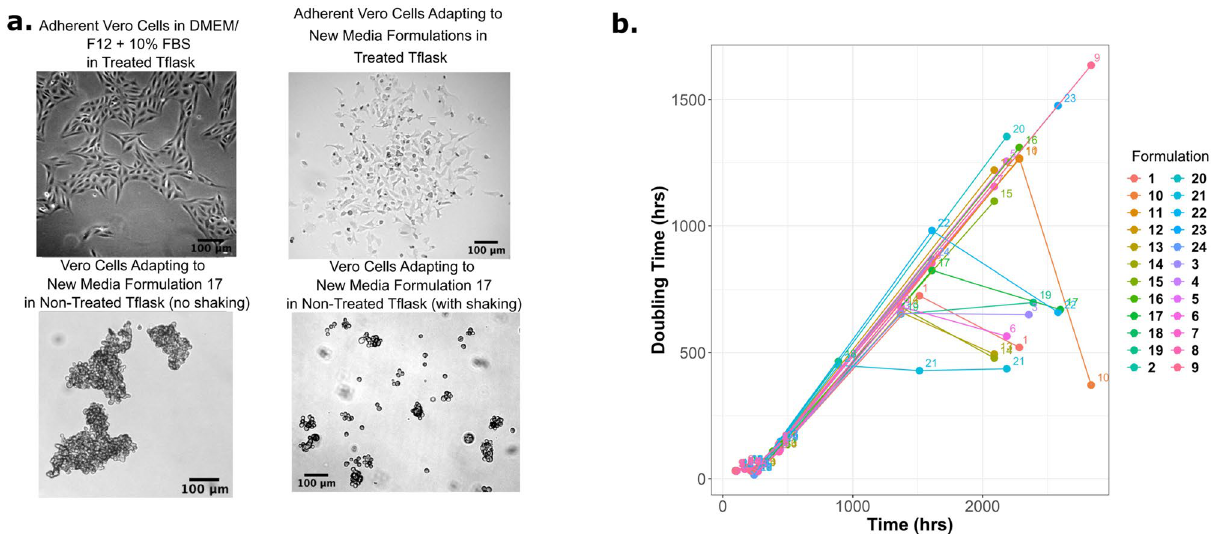
Figure 2. ( a ) Brightfield images of Vero cells as they adapt to low-calcium and magnesium media over the course of 180 days. Vero cells grown in DMEM/F12 + 10% FBS is used as a reference for normal morphology, compared to the cells growing in the chemically defined media (top right image). Vero cells were unable to adhere to non-treated T-flasks in the chemically define media, and with the addition of shaking (40 rpm, bottom right image) single cells and small aggregates were achieved. ( b ) The doubling time of Vero cells increased dramatically as they were adapted to the low-calcium and magnesium media over the course of 118 days. The shortest doubling time at the end of the experiment was approximately 20 days (500